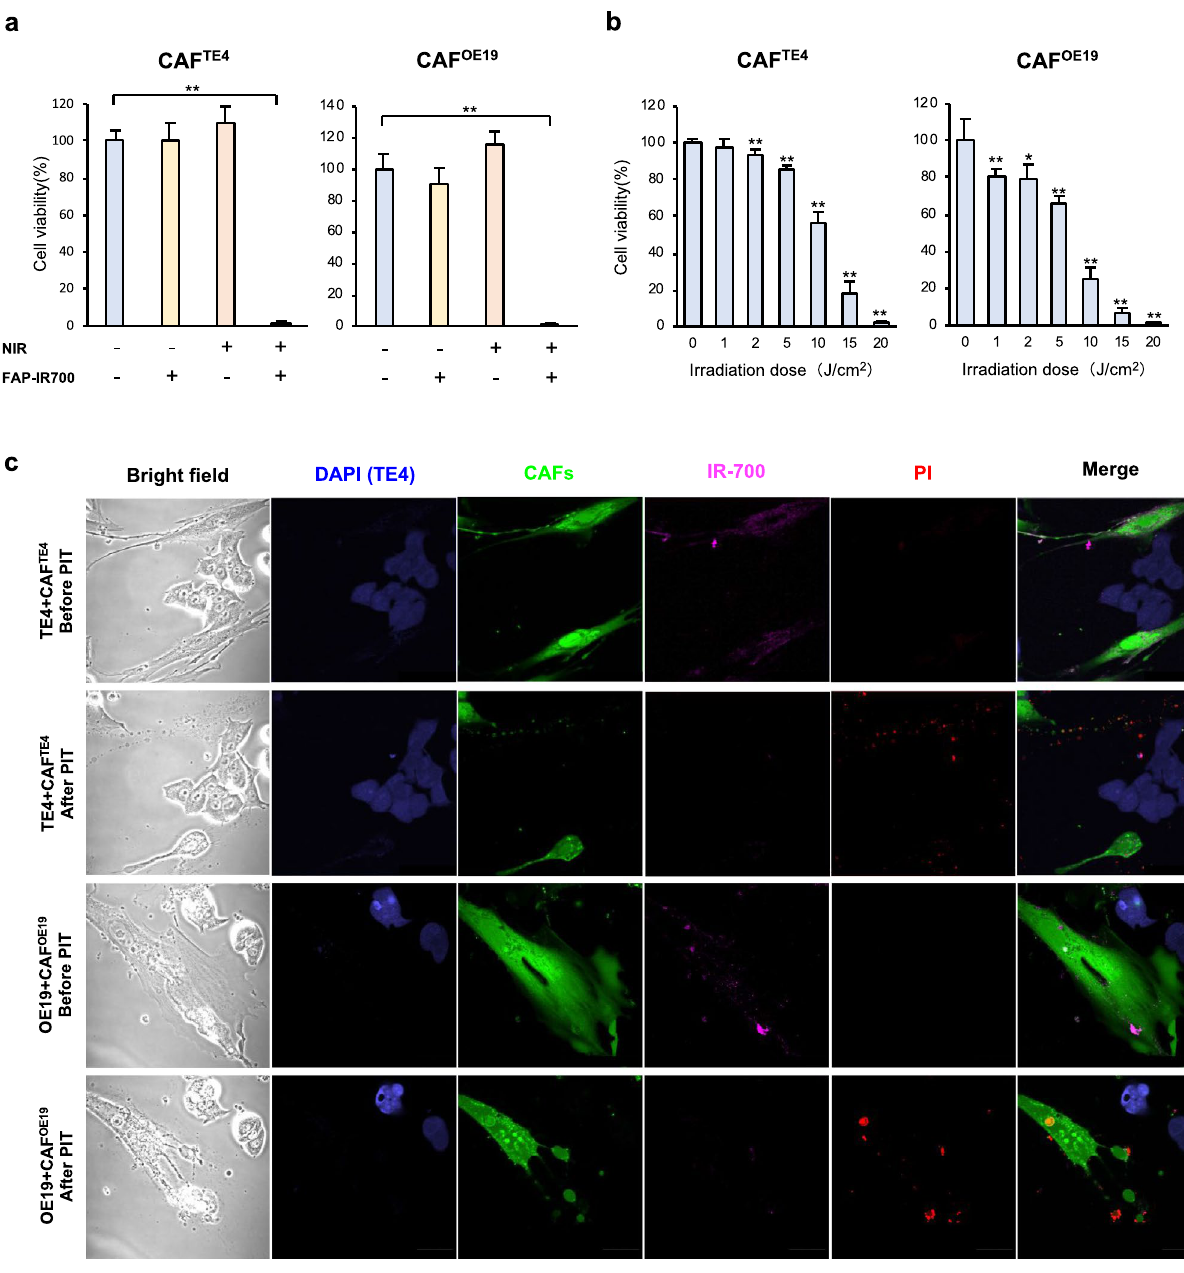
Figure 5. Photoimmunotherapy targeting CAFs expressing FAP induced rapid cell death. ( a , b ) A cell viability assay was performed with EC cells treated with NIR-PIT. ( a ) FEF3 were treated with or without 20 J/cm 2 NIR light irradiation after FAP-IR700 conjugation (20 μg/ml) for 6 h or no conjugation. CAFs were almost dead after conjugation of FAP-IR700 and irradiation. When only FAP-IR700 conjugation or irradiation was performed, CAF viability did not differ significantly. ( b ) NIR-PIT targeting CAFs was evaluated with various irradiation doses of NIR light. The cell viability of CAFs was decreased in an NIR light dose-dependent manner. ( c ) IF imaging shows specific rapid cell death induced by NIR-PIT. After an hour of conjugation with FAP-IR700 (10 μg/ml), cells were irradiated with 5 J/cm 2 NIR light. PI staining indicated that cell membrane destruction was induced by NIR-PIT. CAFs had bleb formation and were stained with PI. Images were acquired at 600 × magnification ( a , b ; data are shown as the mean ± SD, Dunnett test. * P < 0.05, ** P <